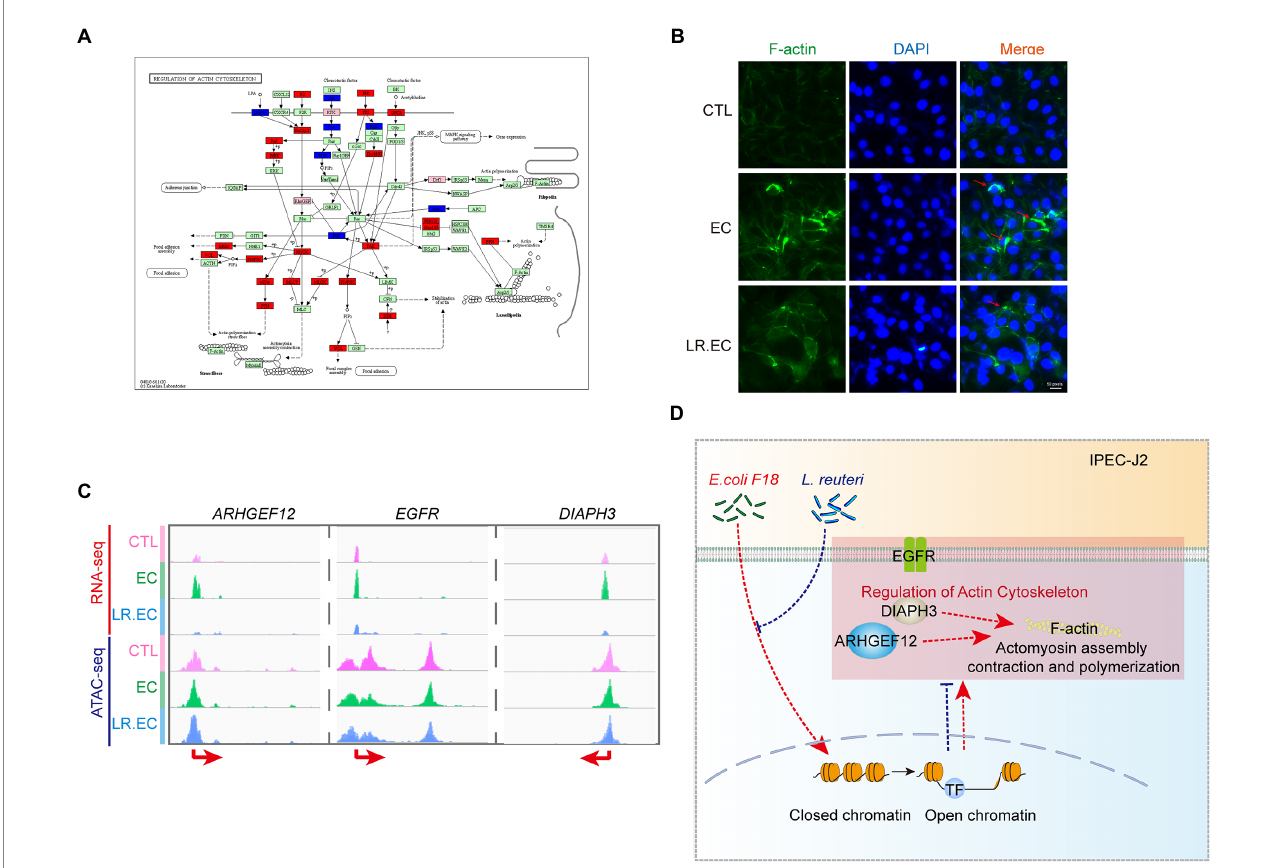
FIGURE 6 Regulation of actin cytoskeleton involved in regulation of L. reuteri- mediated bacteriostasis. (A) KEGG map of regulation of actin cytoskeleton. Red indicates genes identified by RNA-seq, blue indicates genes identified by ATAC-seq, and pink indicates genes identified by both. (B) IFA assay was used to visualize F-actin in different treatments. The red arrows represent the rearrangement and aggregation of F-actin. (C) Visualization of ARHGEF12, EGFR, and DIAPH3 used by IGV in the two datasets. (D) Mechanism hypothesis diagram for the regulation of actin cytoskeleton involved in regulation of L. reuteri- mediated bacteriostasis. Red dashed lines represent the effect of E. coli F18ac, blue dashed lines and crosses represent the effect of L. reuteri